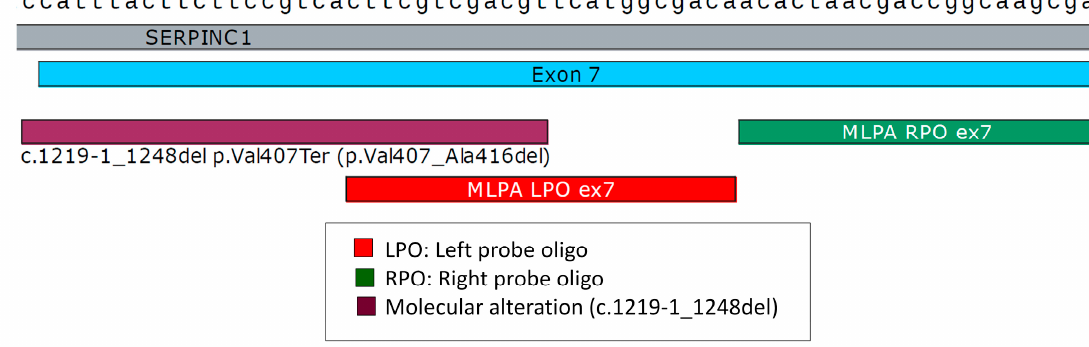
Figure 4. Genetic defect identified in patient P7 by Sanger sequencing: ( A ) electropherogram of the frameshift caused by the 29 bp deletion; ( B ) schematic representation of the location of this small deletion in the SERPINC1 gene. The location of the MLPA probes covering exon 7 (blue) and the small deletionare also shown.